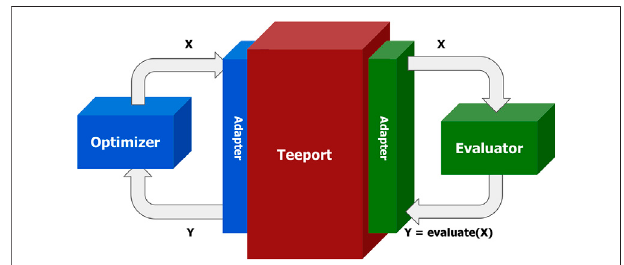
FIGURE 1 | Schematic plot of an optimization loop in Teeport. With the help of the adapters provided by Teeport, the optimizer and the evaluator can exchange data in a normalized